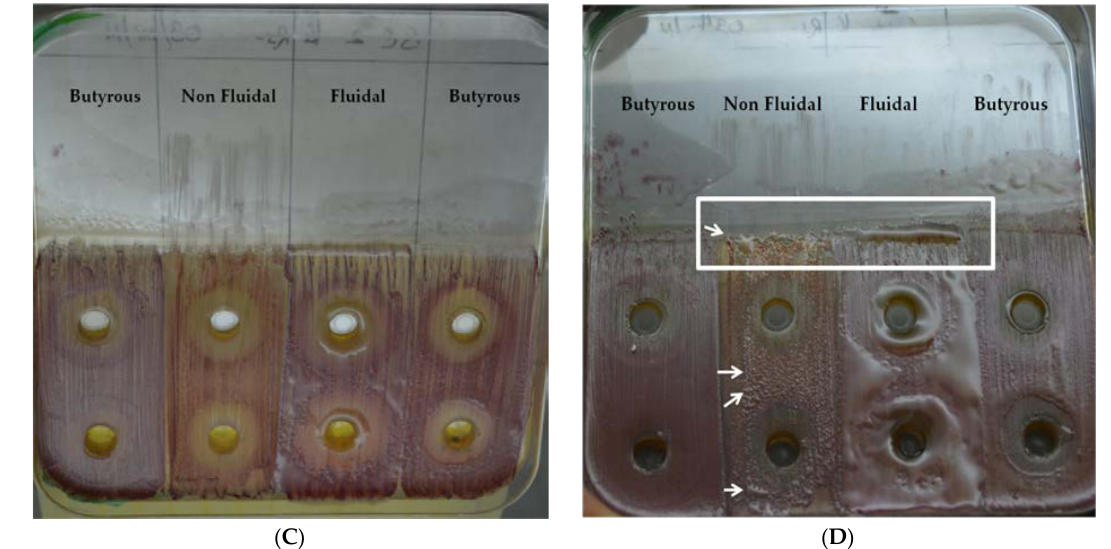
Figure 3. Protocol for induction of virulence colony types in R. solanacearum , using full-strength KMTTC medium. ( A ) Induction of the fluidal colony by Indian gooseberry extract. ( B ) Slanting for induced nutrient deprivation in R. solanacearum . ( C ) Swabbing of R. solanacearum culture differ in colony type in slanting KMTTC agar medium. ( D ) Induction of fluidal colony after three days; white rectangle indicates the effect of nutrient deprivation (slanting edge), whereas white arrows indicate the effect of Indian gooseberry fruit extract; left-to-right sequence = NAIMCC-B-01630 (butyrous), NAIMCC-B-01630 (non-fluidal), NAIMCC-B-01630 (fluidal), and TB-01838 (butyrous).